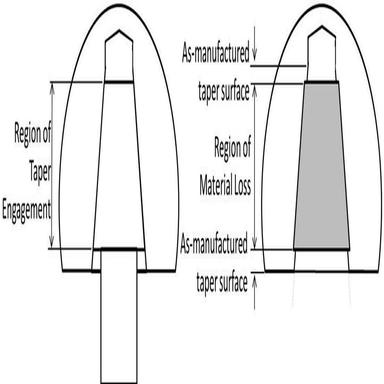
Schematic diagram showing an engaged stem-head couple with a 'Type I ′ engagement pattern.